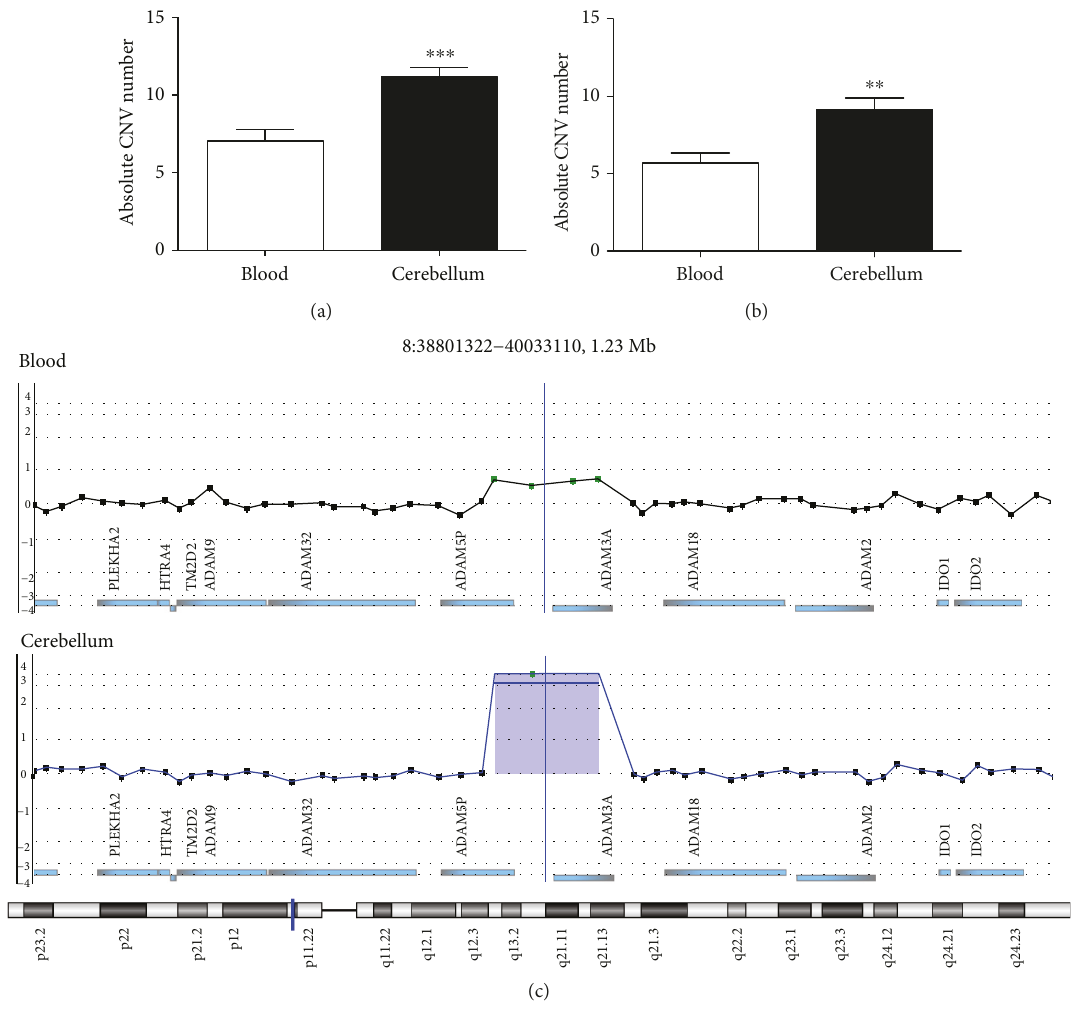
Figure 1: Increase frequency of DNA copy number variation (CNVs) in neural tissue compared to the blood. (a) The mean of the total CNVs detected in independent blood ( n = 24 ) and cerebellum tissue ( n = 71 ) samples; ∗∗∗ p < 0 0001 , Mann – Whitney U test. (b) The mean of the total CNVs detected in paired blood and cerebellum samples from 19 random individuals; ∗∗ p < 0 001 , Mann – Whitney U test. (c) Example of a CNV absent in the blood and observed in the cerebellum. Images extracted from Genomic Workbench